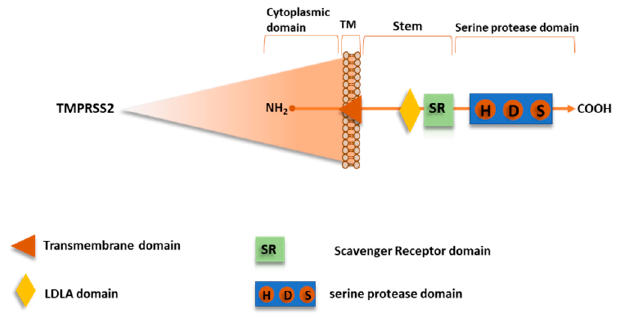
Figure 10. Schematic representation of serine protease TMPRSS2.